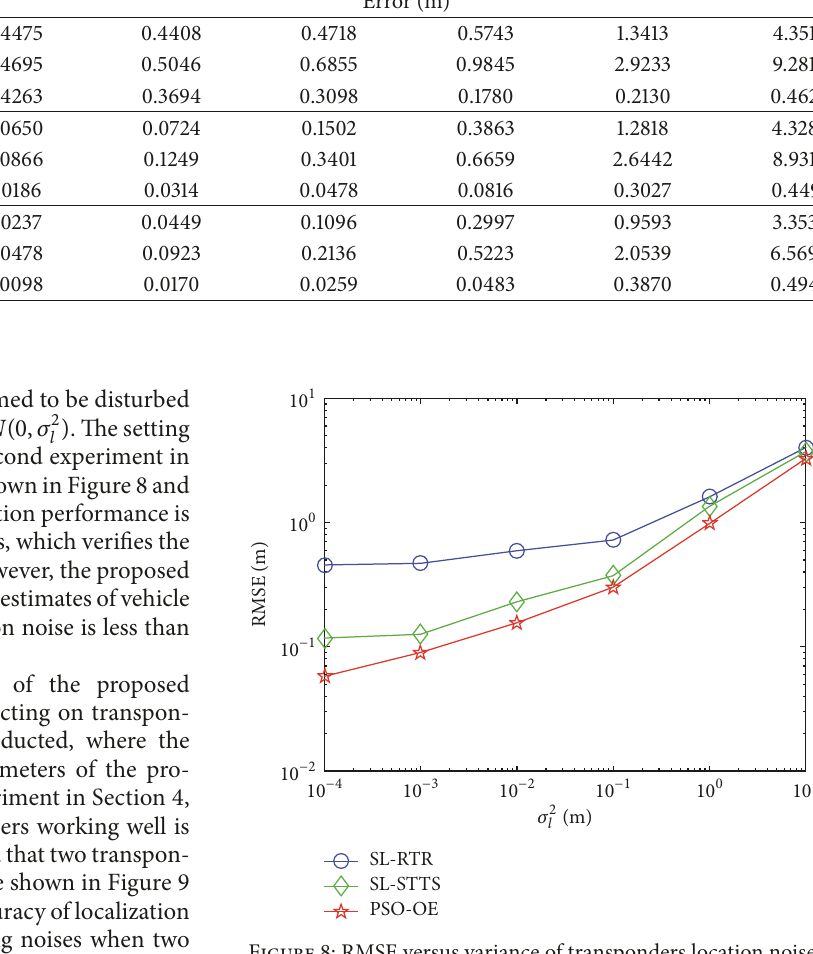
Figure 8: RMSE versus variance of transponders location